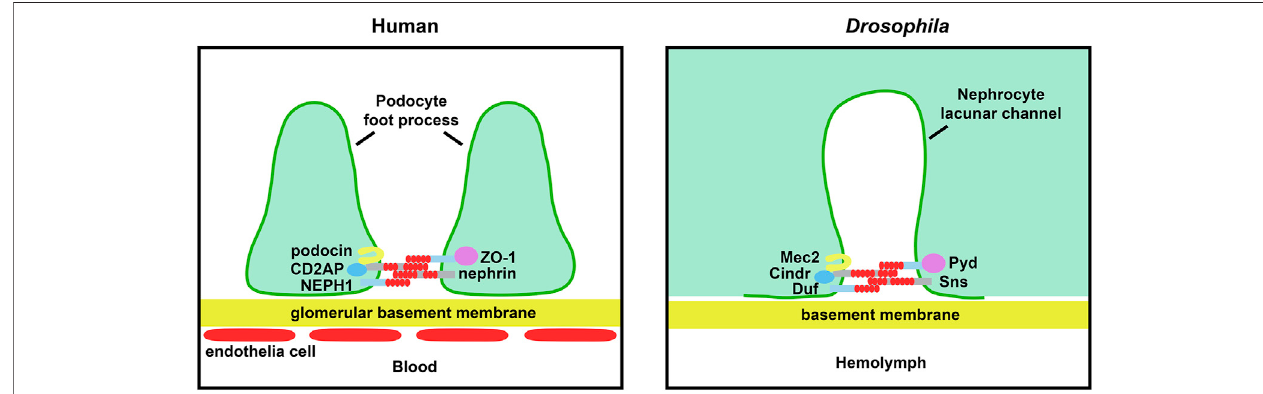
FIGURE1| Schematicofrenal fi ltrationstructure andessentialslitdiaphragmproteins. Theleftpanelshowstheglomerular fi ltrationbarrierstructureinhuman.The blood is fi ltered through fenestrated endothelial cells, glomerular basement membrane and slit diaphragm between the podocyte foot processes. The right panel shows the fi ltration structure inthe Drosophila nephrocyte. Thehemolymphis fi lteredthroughthebasementmembrane andslitdiaphragm locatedattheopeningofthelacunar channels. The core components of the slit diaphragm are highly conserved between fl y and human.